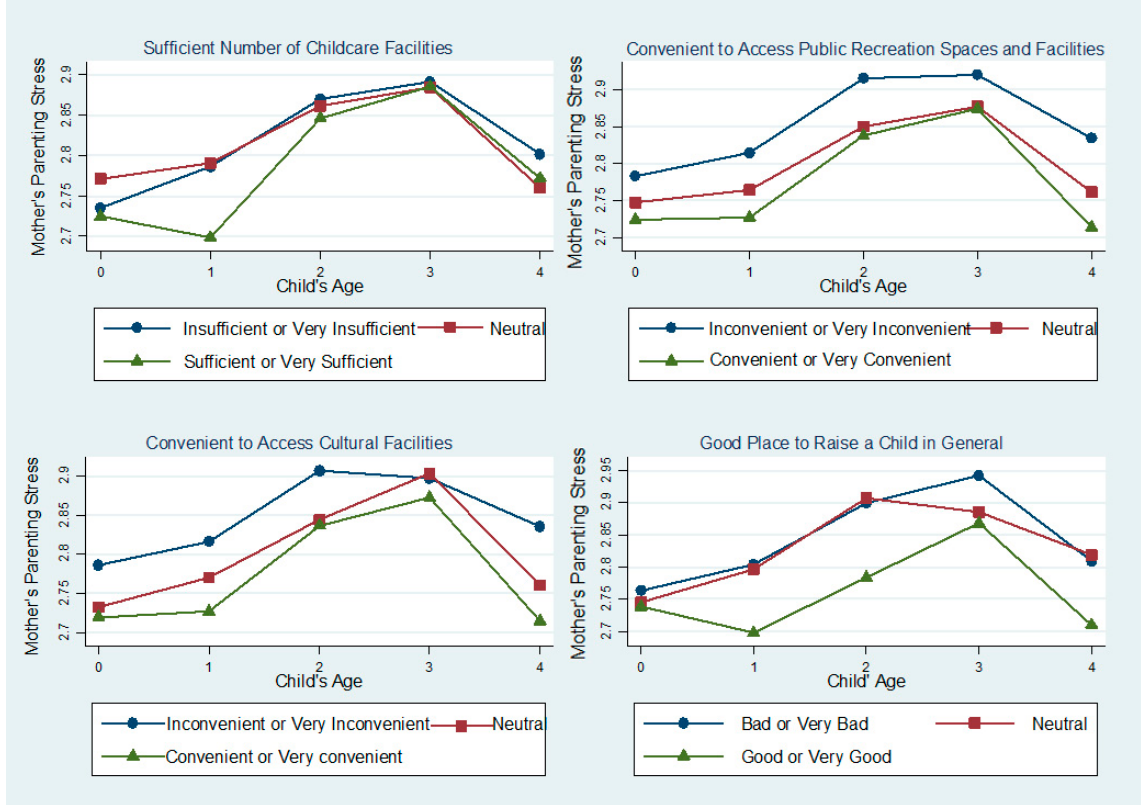
Figure 4. Parenting Stress and Neighborhood Characteristics by Children’s